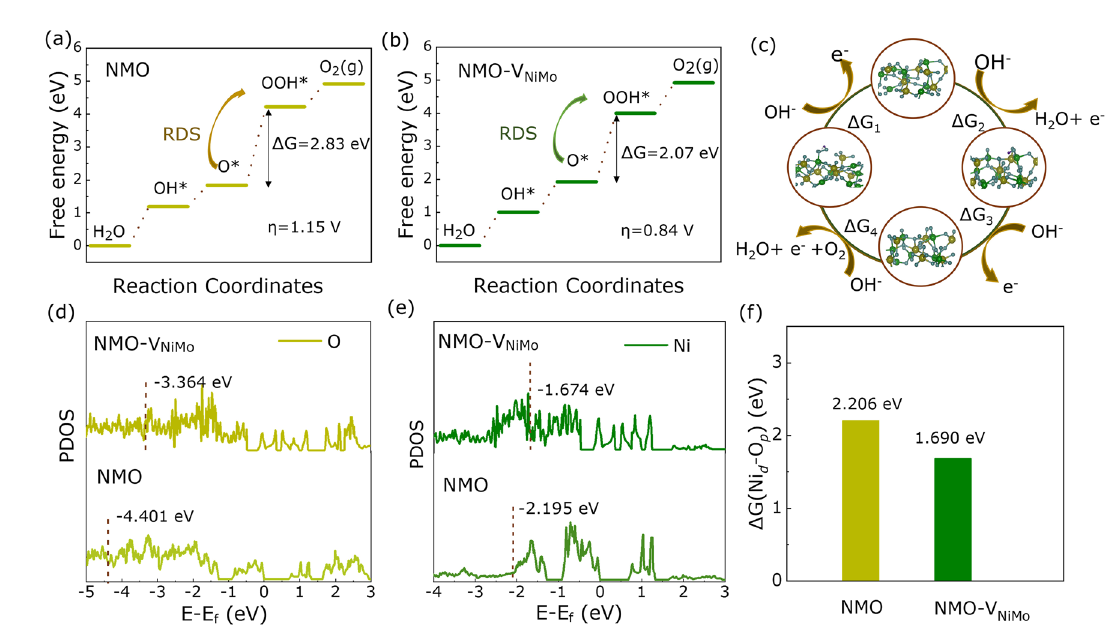
Fig. 4 DFT calculation of NMO and NMO-V NiMo . Free energy diagram of OER steps on a NMO and b NMO-V NiMo . c Schematic of a four-step mechanism of OER. Partial DOS of d NMO and e NMO-V NiMo . f Energy difference of Ni d and O p in NMO and NMO-V